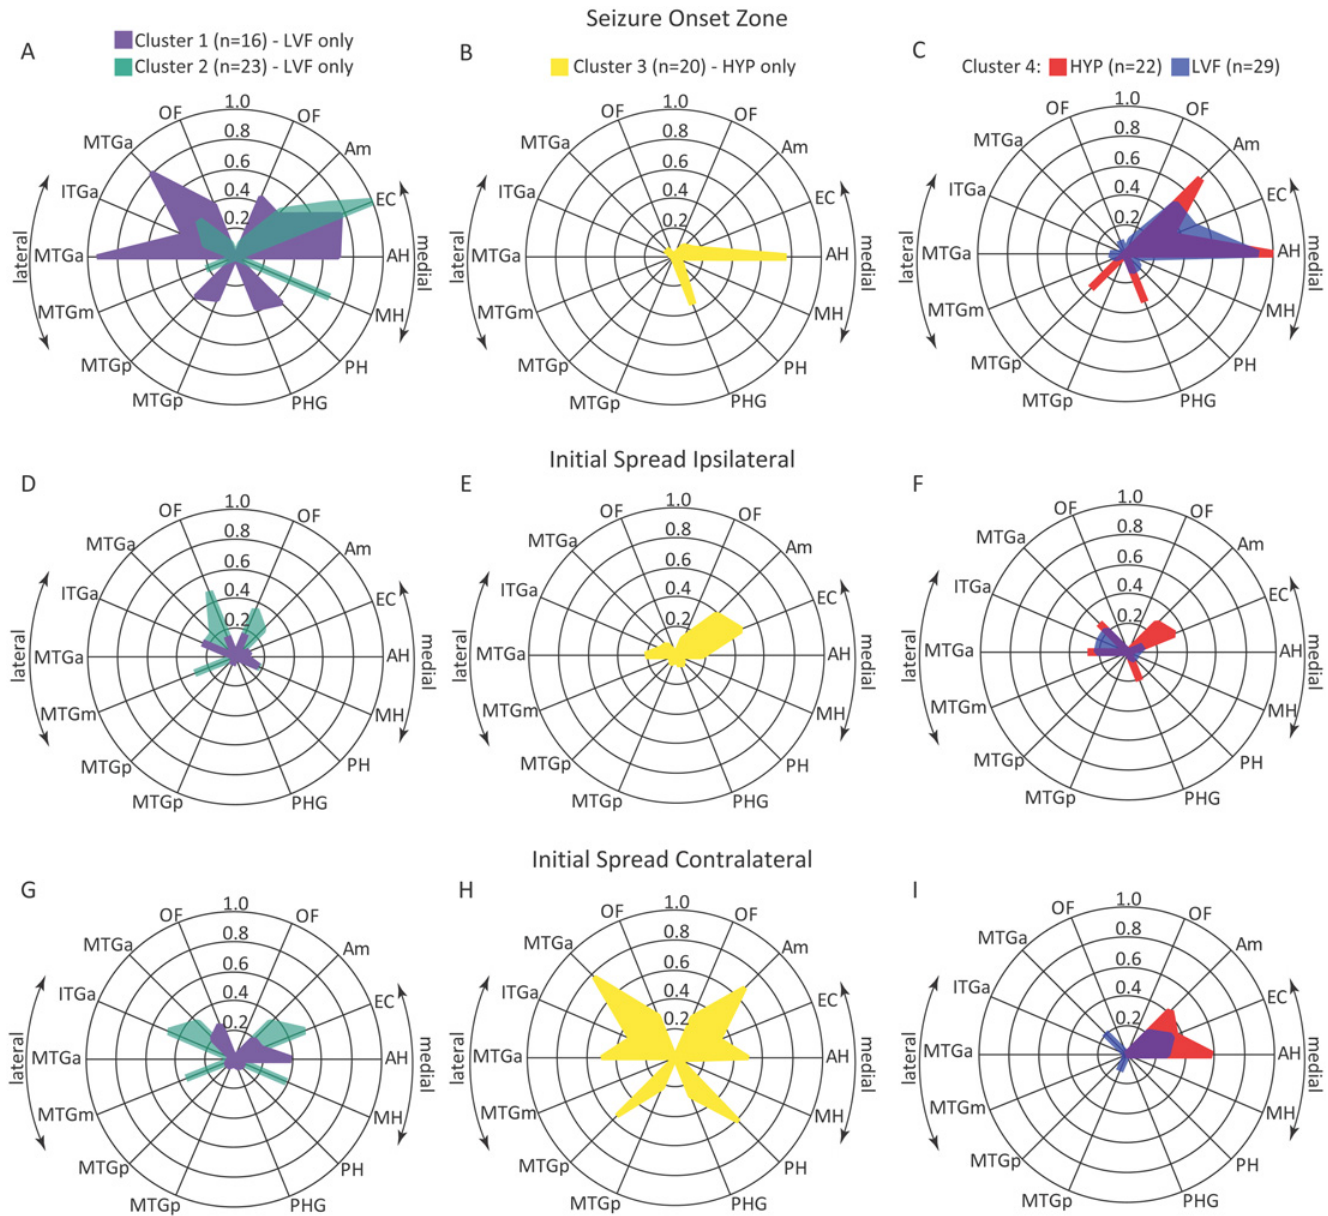
Fig 2. Radar plot illustrating the results of cluster analysis using anatomical /electrode sites(s) of the SOZ and initial seizure spread. Involvement of each recording site (denoted by radii on each plot) in the SOZ (top row A-C), sites of initial ipsilateral spread (middle row D-F) and initial contralateral spread (bottom row G-I) is expressed as the proportion of total seizures in each cluster (n) indicated by the concentric circles in each plot. Right and left halves of each plot depict medial and lateral aspects respectively of temporal and frontal lobe that included orbitofrontal (OF), amygdala (Am), entorhinal cortex (EC), anterior (AH), middle (MH) and posterior hippocampus (PH), parahippocampal gyrus (PHG), and anterior (a), middle (m), and posterior (p) regions of inferior (ITG) and middle temporal gyri (MTG).